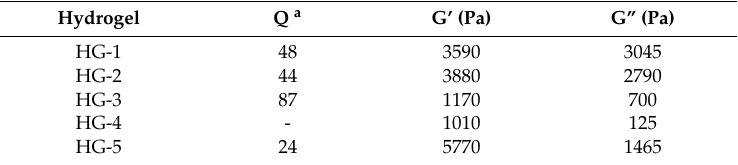
Figure 7. Frequency dependent measurements of G’ and G’’ of hydrogel series: ( a ) HG-1 to HG-5, ( b ) HG-6H to HG-9H at 22 °C. Table 3. Storage (G (cid:48) ) and loss (G”) moduli (at ω = 10 rad / s) of hydrogel series HG-1 to HG-5 at 22 ◦ C.